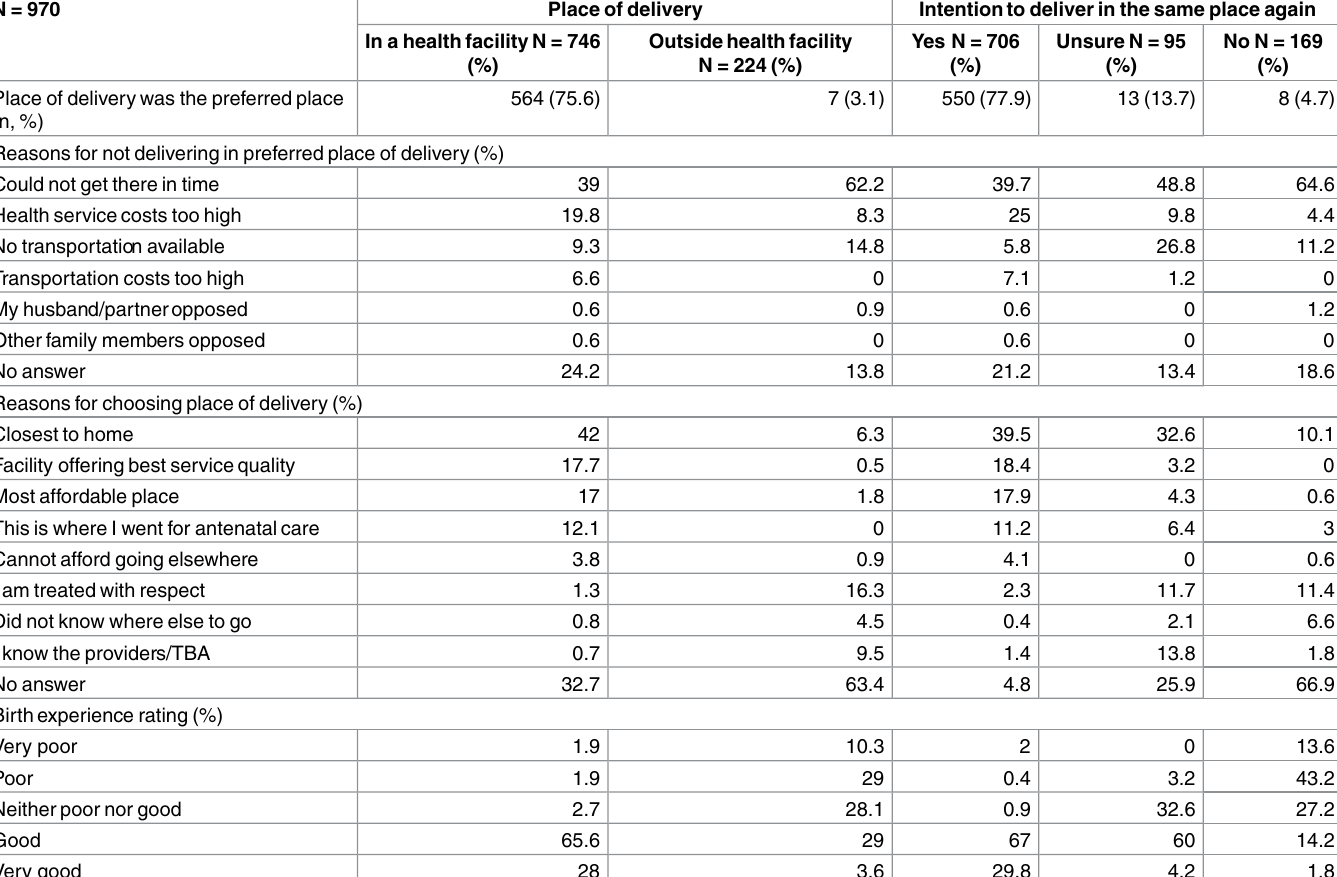
Table 5. Reasonsfor choosing specificplaceof deliveryand self-rated